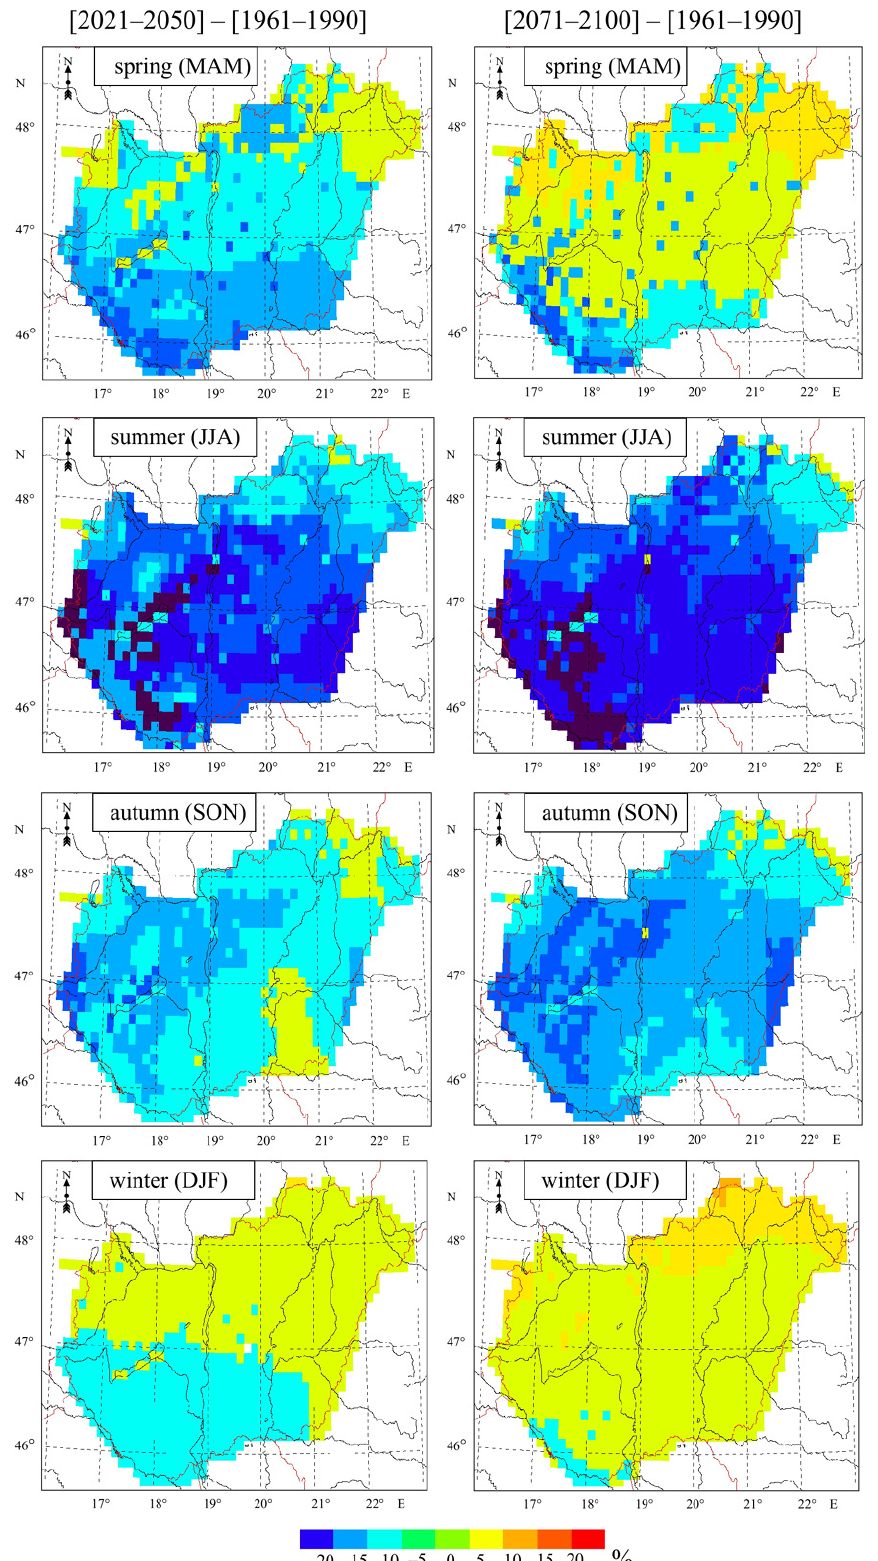
Figure 5. Spatial distribution of relative di ff erences between ozone deposition velocities in each period for four seasons.